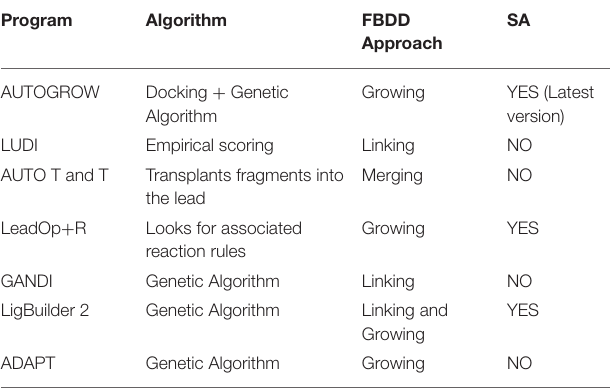
TABLE 1 | FBDD programs with respective